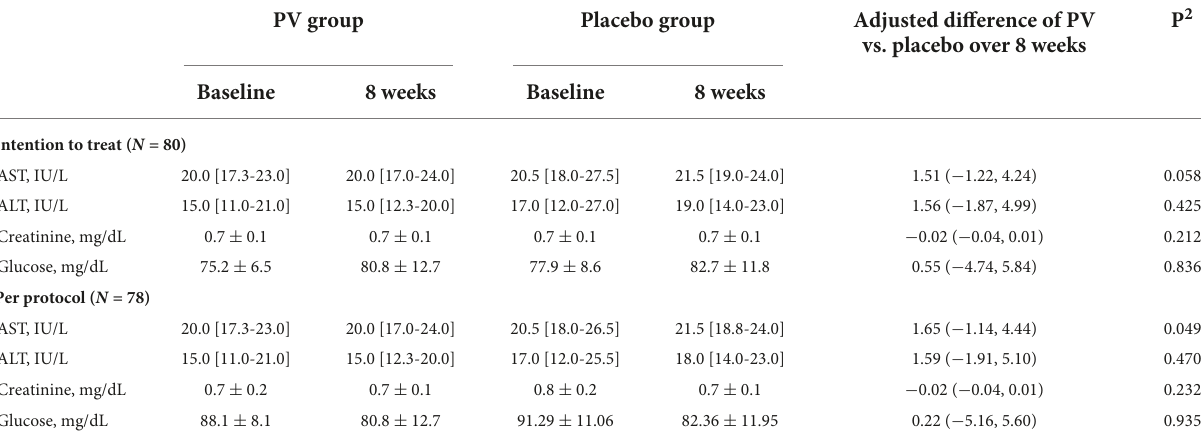
TABLE 5 Laboratory findings evaluating the adverse effects and the additional benefits profile 1 . PV group Placebo group Adjusted difference of PV